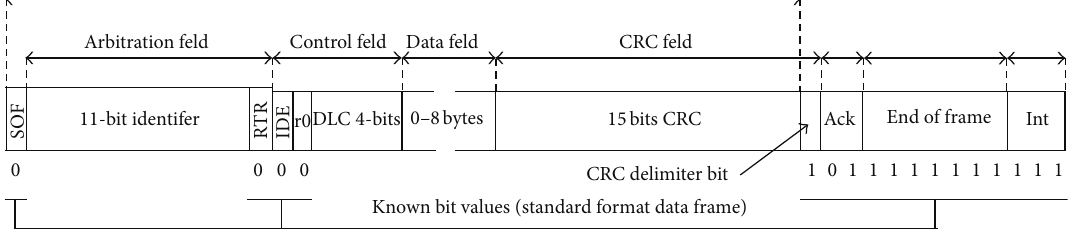
Figure 4: Standard CAN message format